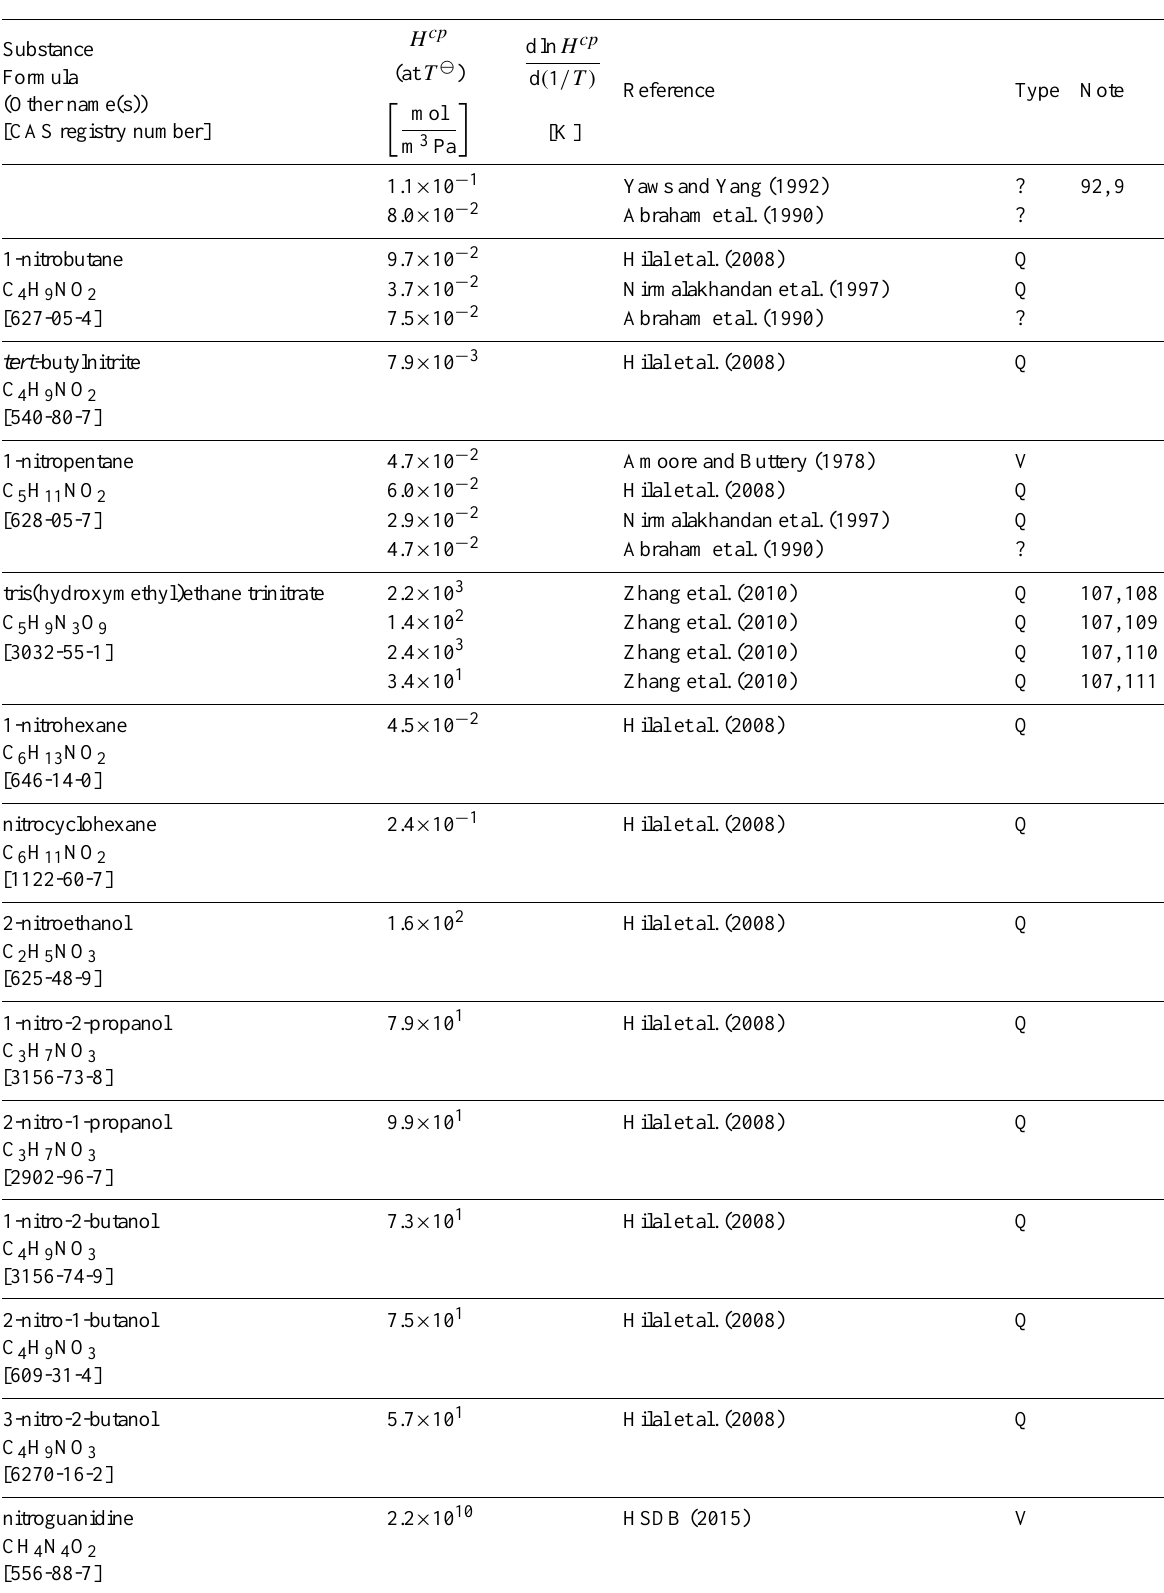
Table 6: Henry’s law constants for water as solvent